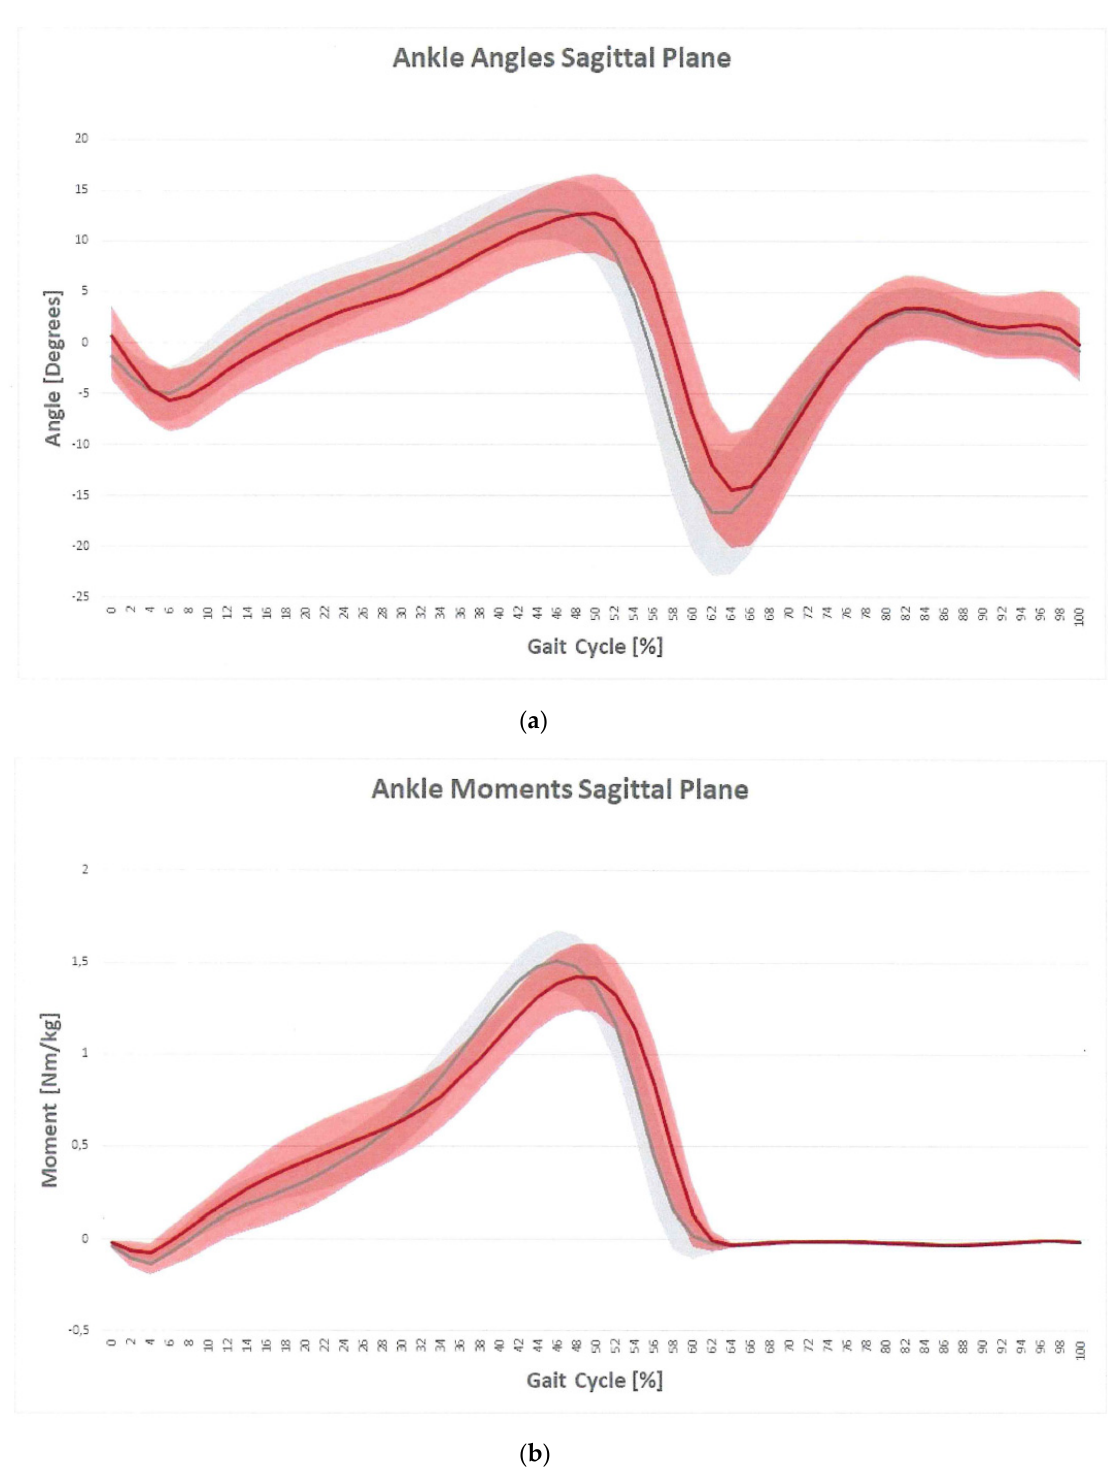
Figure 3. Ankle angles plot on sagittal plane ( a ) and ankle moment plot on sagittal plane ( b ) for OG (red) and CG (gray). The vertical line is representative of